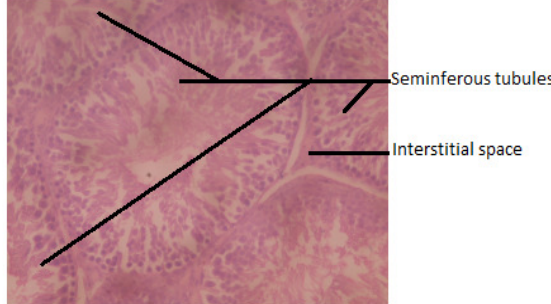
Fig. 1. Photomicrograph of transverse section of typical testicular tissue from group 1 rats (x400 magnification; H&E) Slide show normal testicular tissue containing spermatogenic cells and mature spermatozoa. Interstitial cells of Leydig are essentially normal